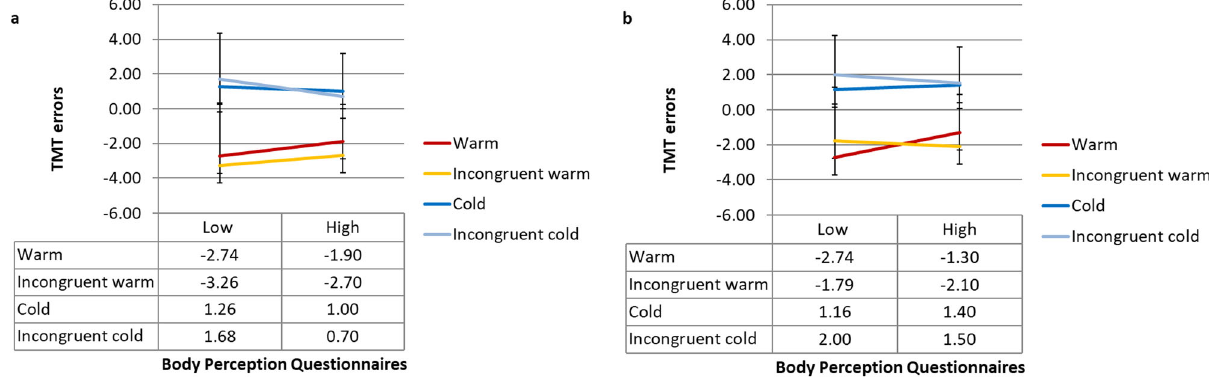
Fig. 2 Visuo-thermal illusion effect following the illusion trials as a function of Body Perception Questionnaires (BPQ) scores for Experiment 1. For the increasing ( a ) and the decreasing conditions ( b ). For visualisation purposes, we used a median split method to categorise BPQ outcomes into low and high score groups. Error bars denote ±1 standard error of the mean. See Supplementary Fig. 3 for fi gures with individual data